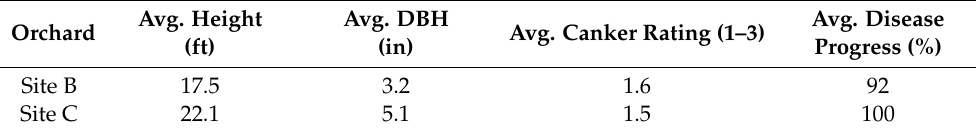
Table 1. Visual characteristics. Measurements and canker ratings from 2011.